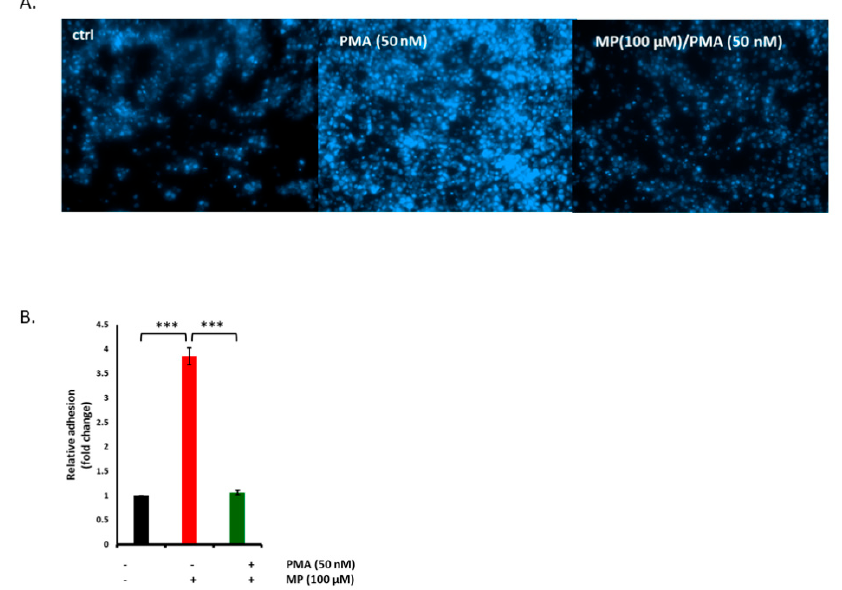
Figure 10. MP abolishes phorbol myristate acetate (PMA)-evoked adhesion THP-1 cells to VSMCs . Cells were treated with PMA (50 nM) in presence or absence of MP (100 µ M), and adhesion of THP-1 cells was examined by monocyte adhesion assay ( A ). Representative photomicrographs of the e ff ect of MP on THP-1 adhesion to VSMC. ( B ) Quantitation of mean fluorescence intensity of adherent THP-1, assessed at 5 di ff erent regions; *** p < 0.001. Values are represented as mean ± SEM of relative